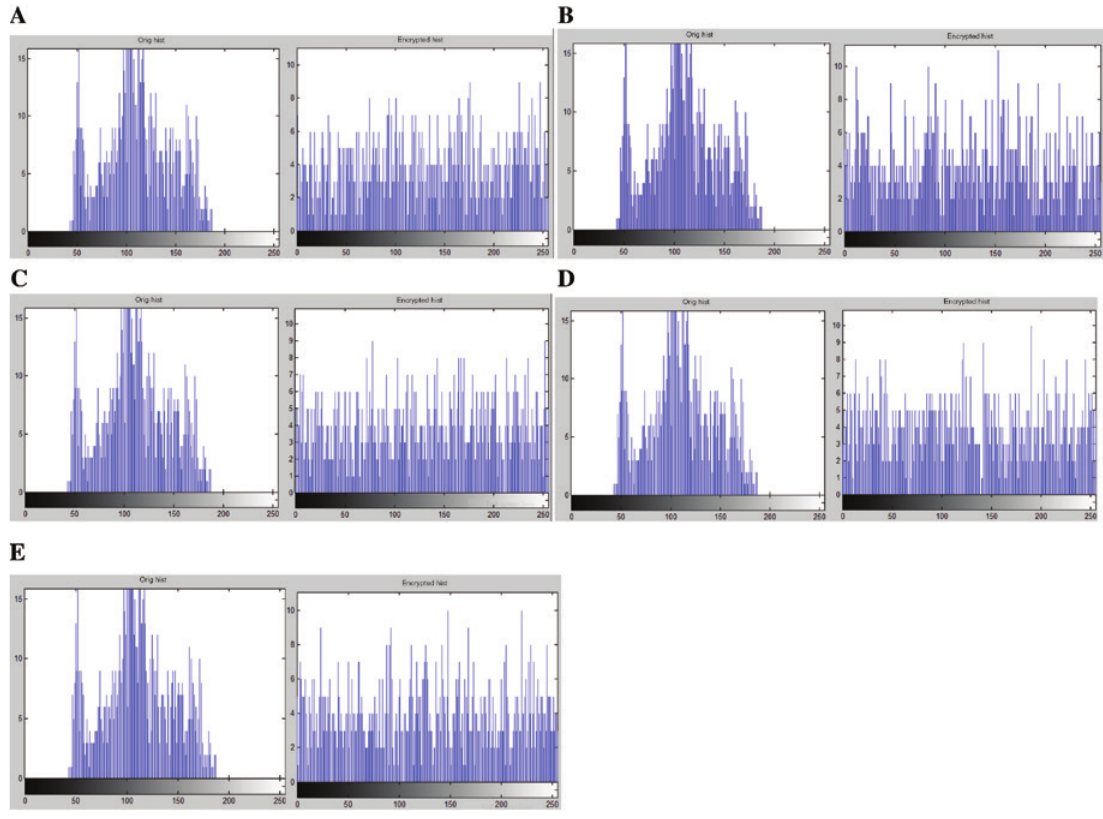
Figure 3: Histogram of Figure 1D Using Transformed Logistic Map.